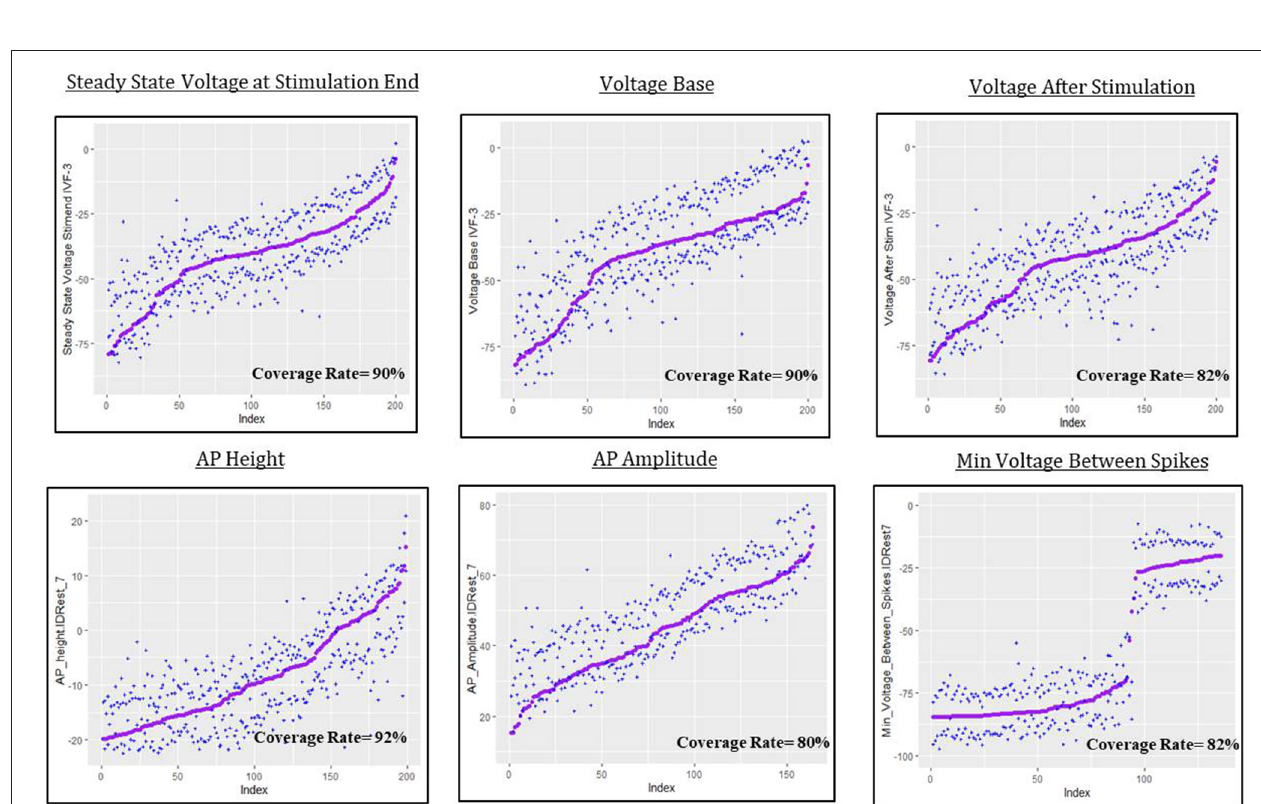
FIGURE 9 | Predictive uncertainty plots for GP emulator predictions of the six electrical features considered here.